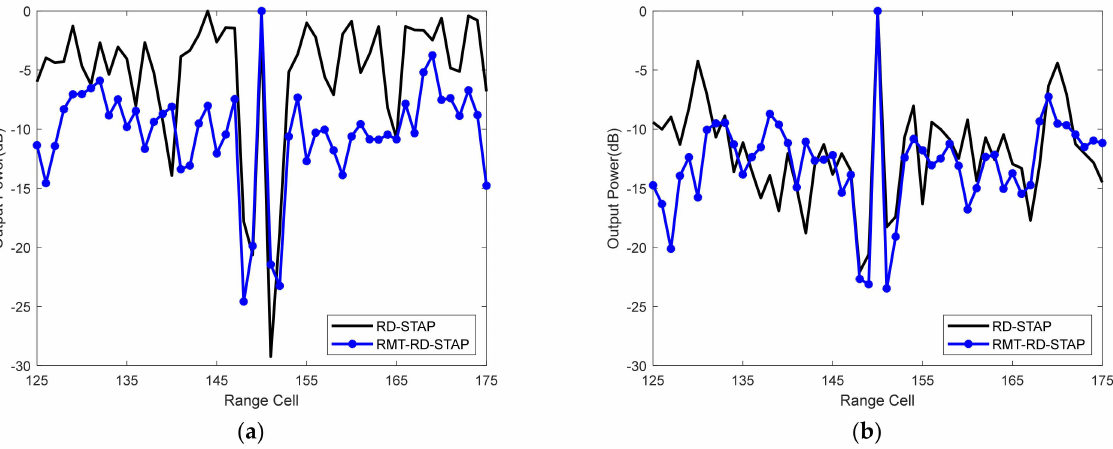
Figure 9. Output power versus range cell. ( a ) L = 45 training samples and ( b ) L = 95 training